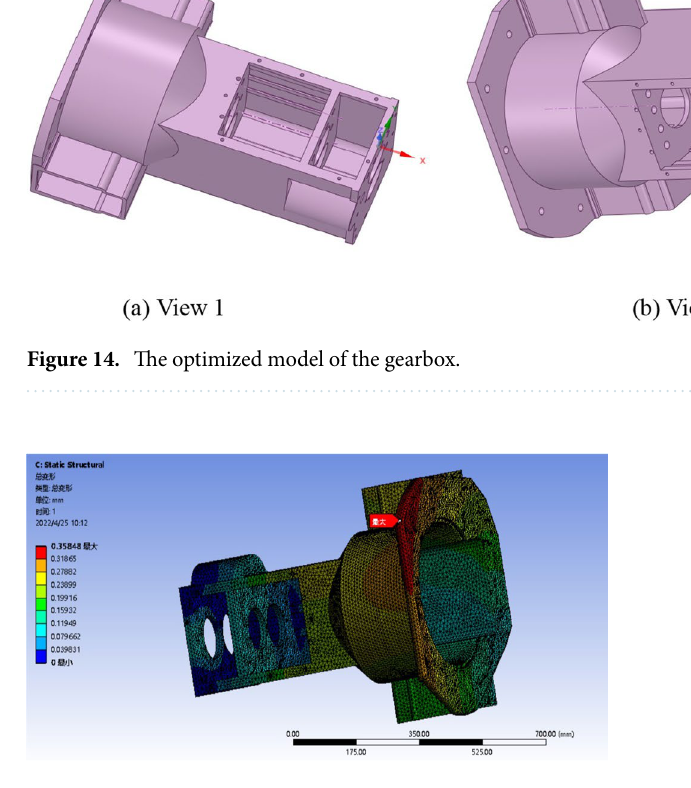
Figure 15. Four deformation nephogram of working condition.